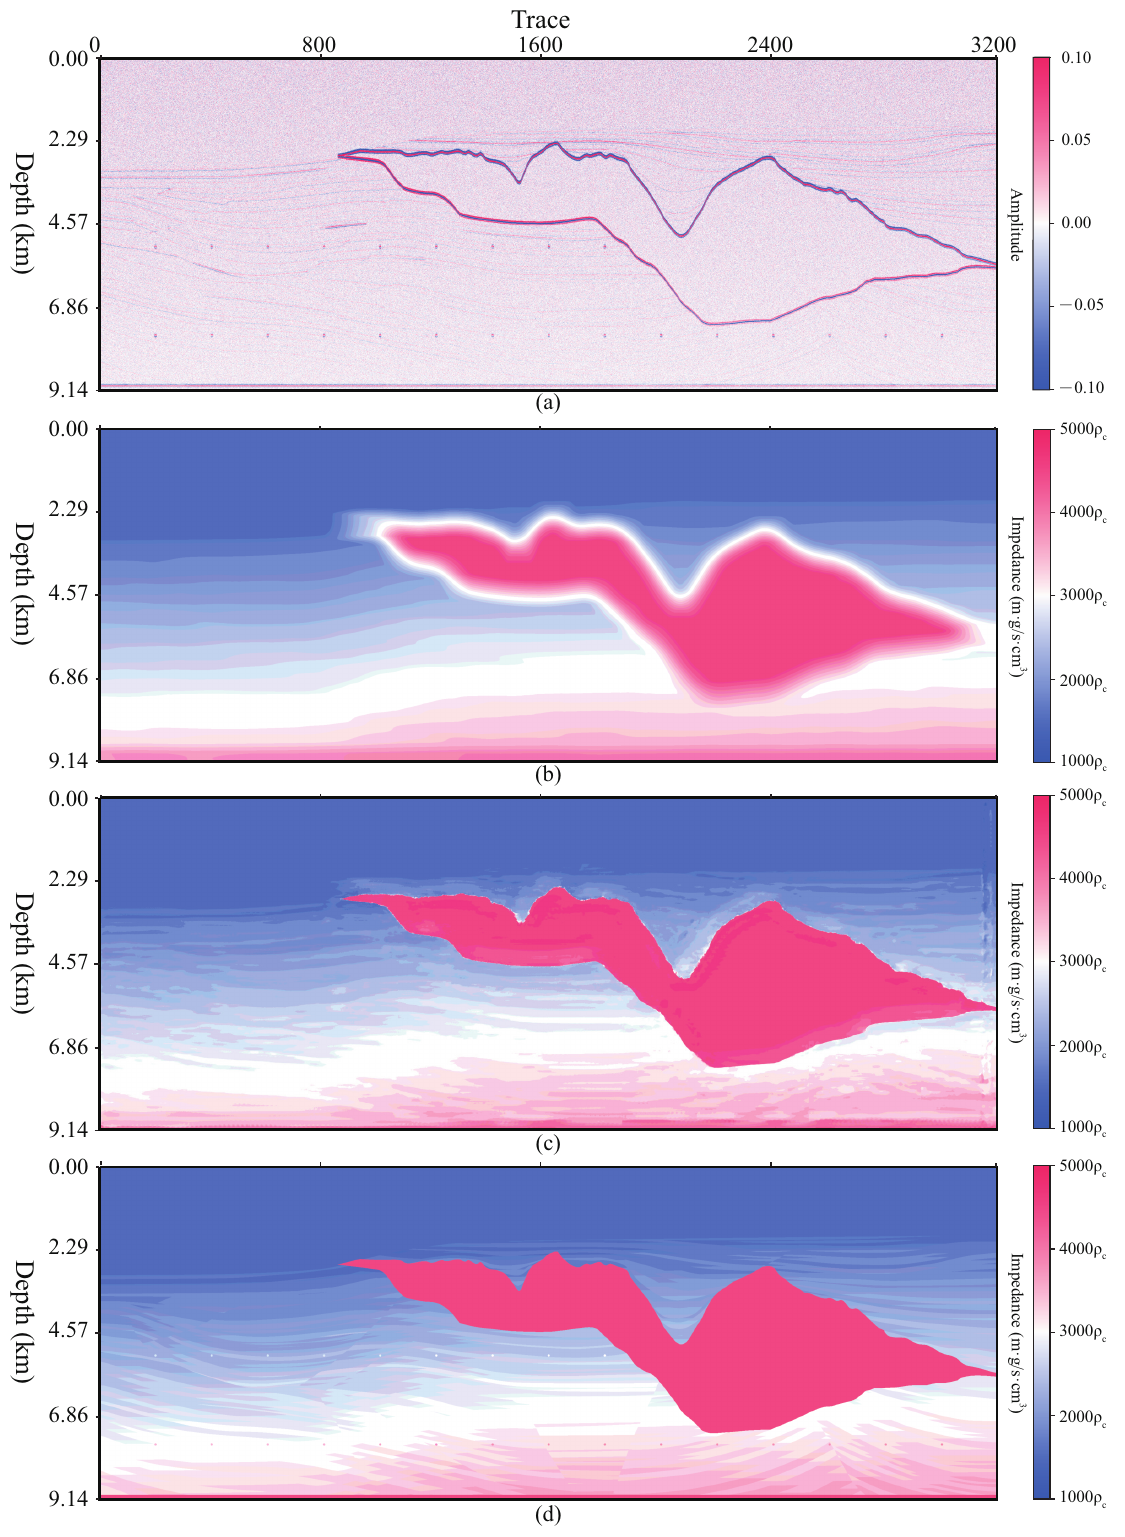
Figure 14. Test result of the Sigsbee 2A profile, ( a ) M , K = 0.017, SNR = 0.00 dB, P = 41 ◦ , channel 1 of input data, ( b ) B , channel 2 of input data, ( c ) predicted profile ˆZ , PCC = 0.9684, R 2 = 0.8703, SSIM = 0.7286, PSNR = 21.11 dB. ( d ) label profile Z